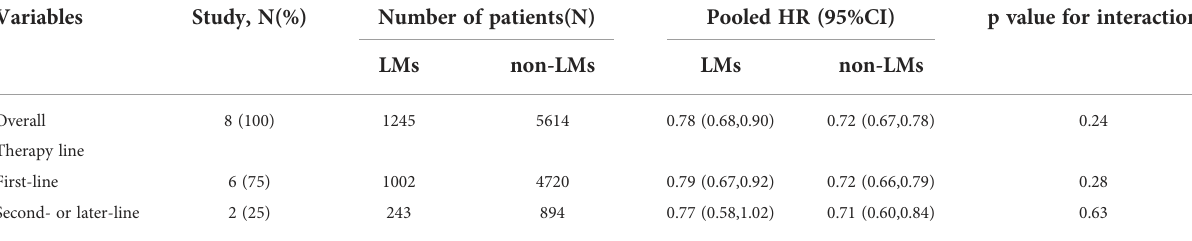
TABLE 2 Analyses of NSCLC pooled hazard ratios for OS outcomes by subgroup. Variables